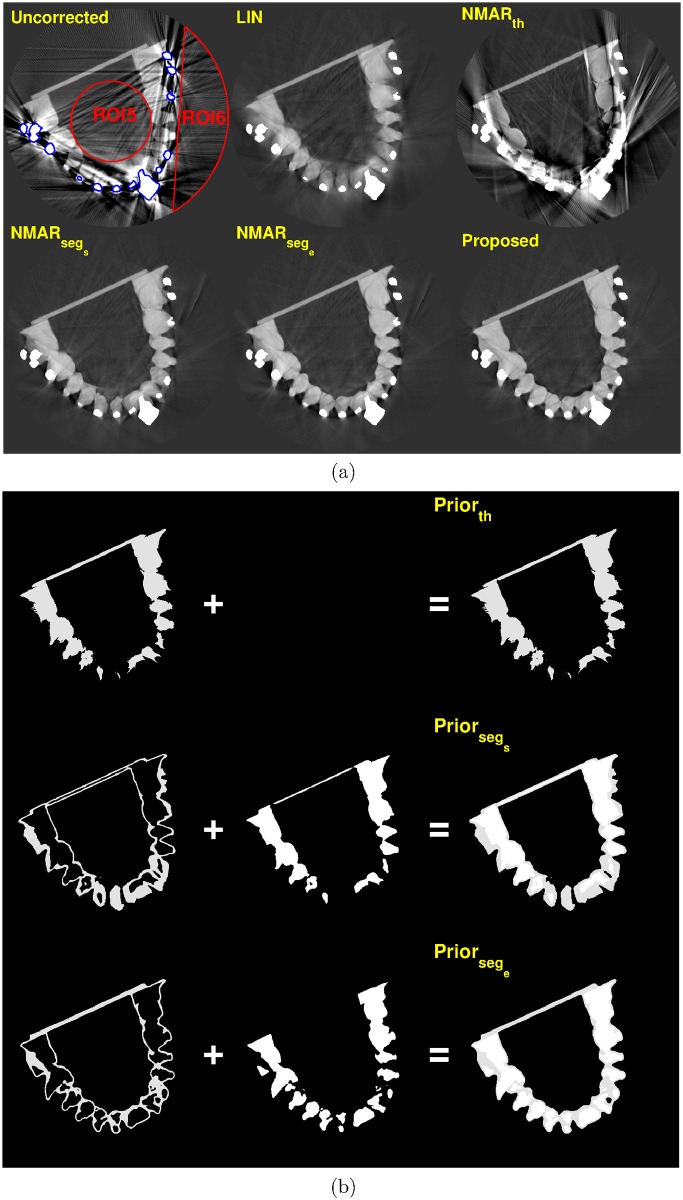
Results of tooth phantom with orthodontic bracket, on slice # 155 (C = -250 HU/W = 1250 HU).(a) Top row: reconstruction images by (left) Uncorrected, (middle) LIN, and (right) NMARth images. Bottom row: reconstruction images by (left) NMARsegs, (middle) NMARsege, and (right) the proposed results. ROI 5 and ROI 6 are indicated by red lines on the uncorrected image. (b) Prior images by (top) simple thresholding, (middle) RAC segmentation of LIN image, and (bottom) RAC segmentation of final iteration image.